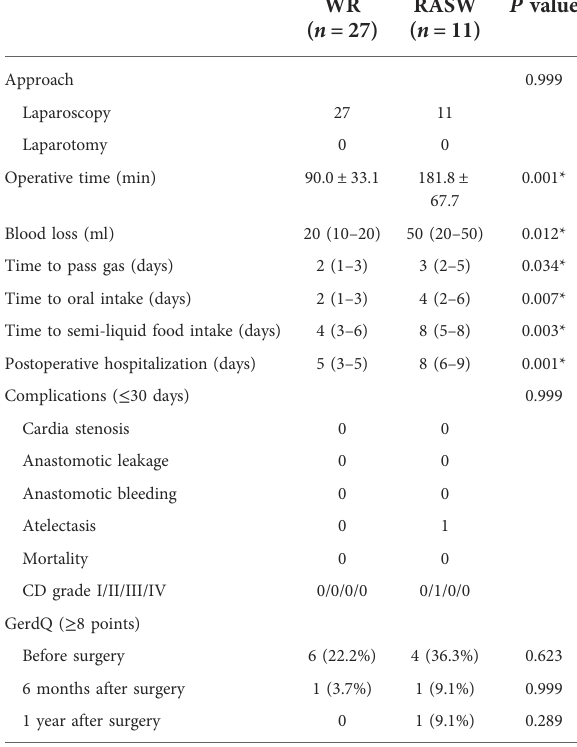
TABLE 2 The perioperative outcomes and follow up of the patients.